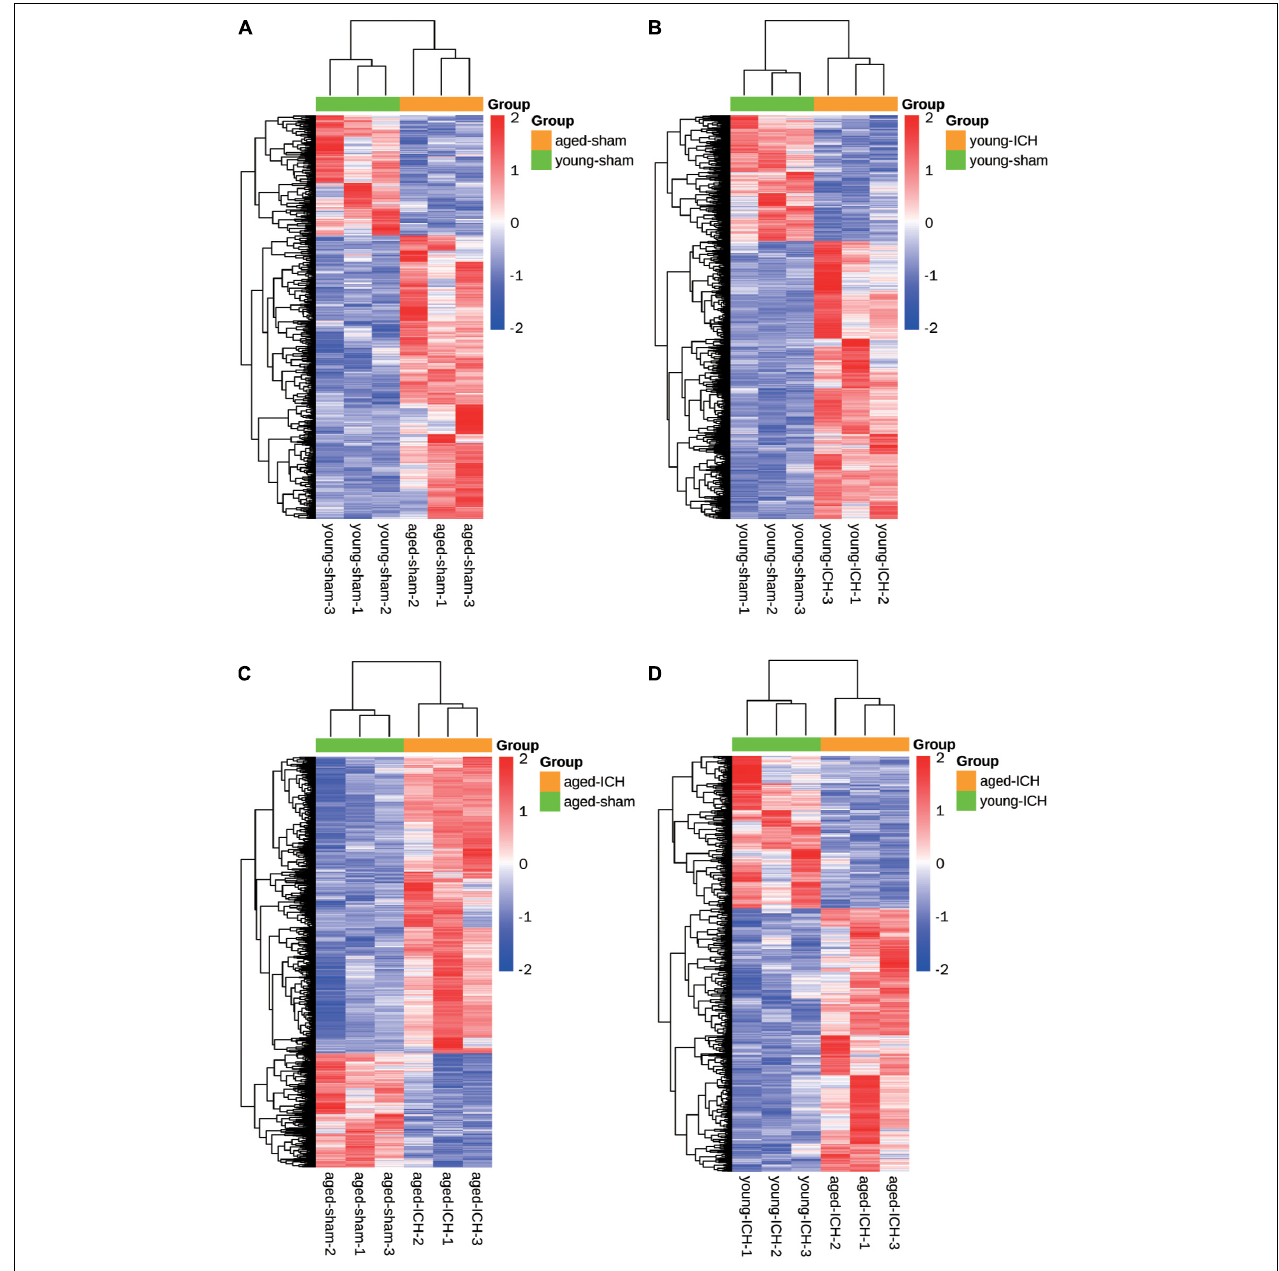
FIGURE 2 | Heatmaps of different pairwise comparisons. The criterion for identification DEGs is FC > 1.5 or FC < 0.67, P < 0.05. (A) Young sham vs. aged sham. (B) Young ICH vs. young sham. (C) Aged ICH vs aged sham. (D) Aged ICH vs. Young ICH. ICH, intracerebral